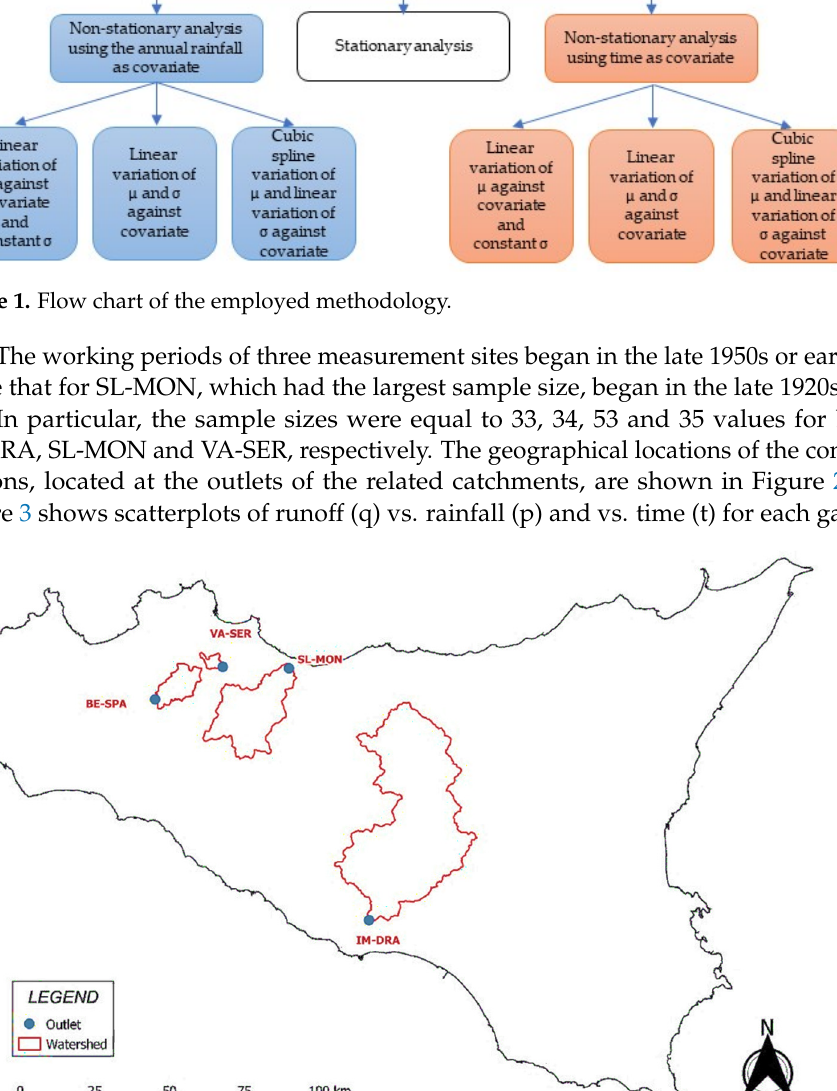
Figure 3. Scatterplots of annual runoff vs. rainfall ( first row ) and annual runoff vs. time ( second row ) for IM-DRA, BE-SPA, SL-MON and VA-SER. 2.2. The Generalized Additive Models in Location, Scale and Shape (GAMLSS) Framework In this study, a general class of regression models, widely known as Generalized Ad- ditive Models in Location, Scale and Shape (GAMLSS), was adopted to carry out the sta- tionary and non-stationary runoff frequency analyses. In GAMLSS, the exponential family distribution assumption for the response varia- ble y is relaxed and replaced by a general distribution family, including highly skewed and/or kurtotic distributions. The systematic part of the model is extended to allow mod- eling not only of the mean but also of the other parameters of the distribution. This can be carried out by means of linear parametric and/or additive non-parametric functions of